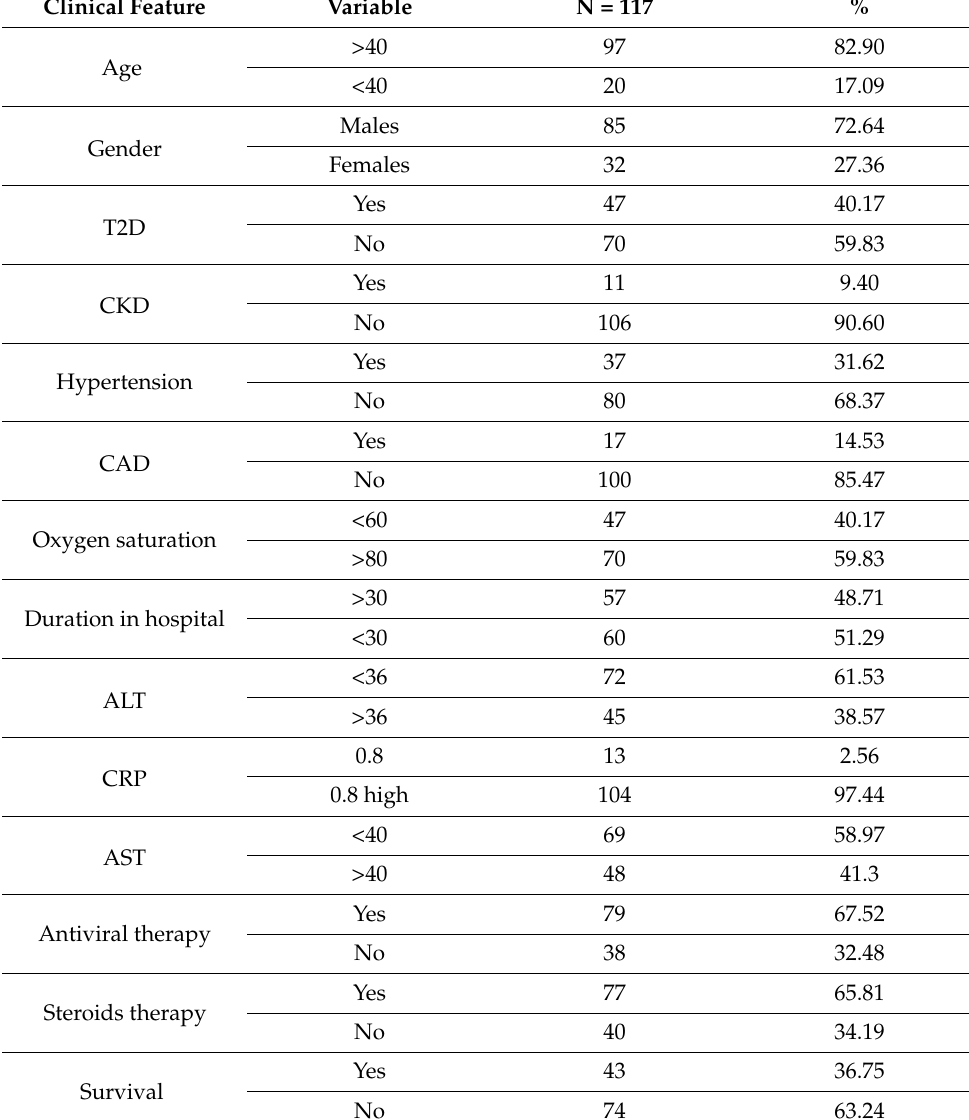
Table 2. Baseline characteristics of the COVID-19 patients. T2D—type2 diabetes; CKD—chronic kidney disease; CAD—coronary artery disease; SpO 2 —partial pressure of oxygen; ALT—alanine